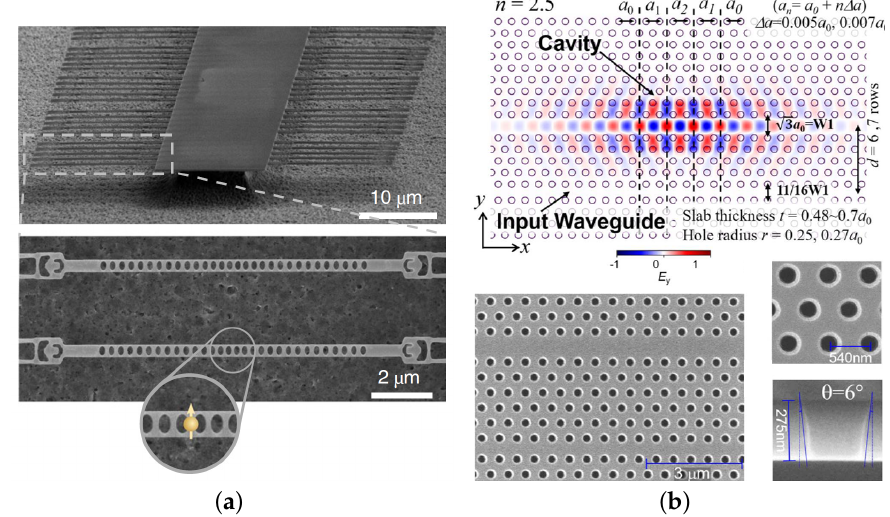
Figure 5. Scanning electron microscope images of ( a ) 1D photonic crystal nanobeam cavities, reprinted with permission from [52] and ( b ) 2D photonic crystal heterostructure cavity, reprinted with permis- sion from [50] ©The Optical